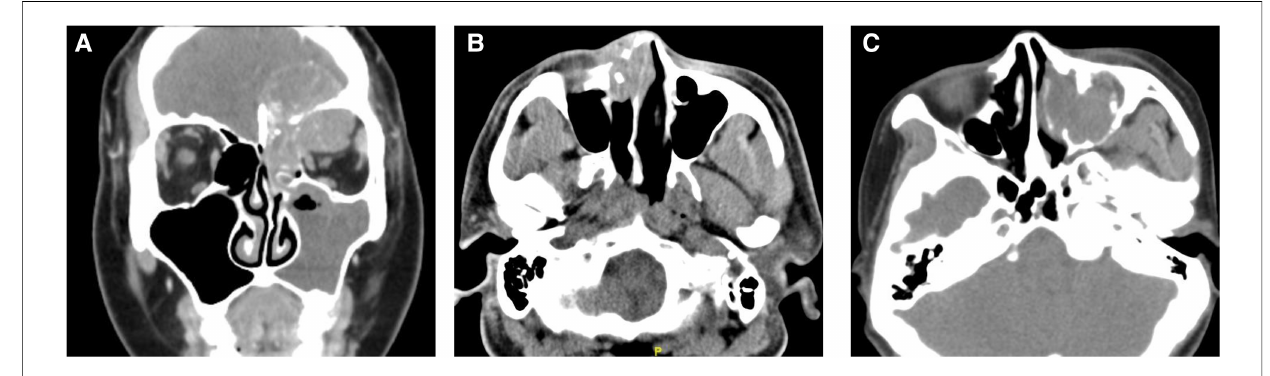
FIGURE 1 Computed tomography (CT) images of NUT carcinoma cases. ( A ) Coronal enhanced CT of case 1: the mass involved the left orbit, ethmoid sinus, and cranium. ( B ) Axial CT showed the tumor of case 2 located in the nasal cavity and destroyed the surrounding bone. ( C ) CT suggested a mass in the left maxillary sinus of case